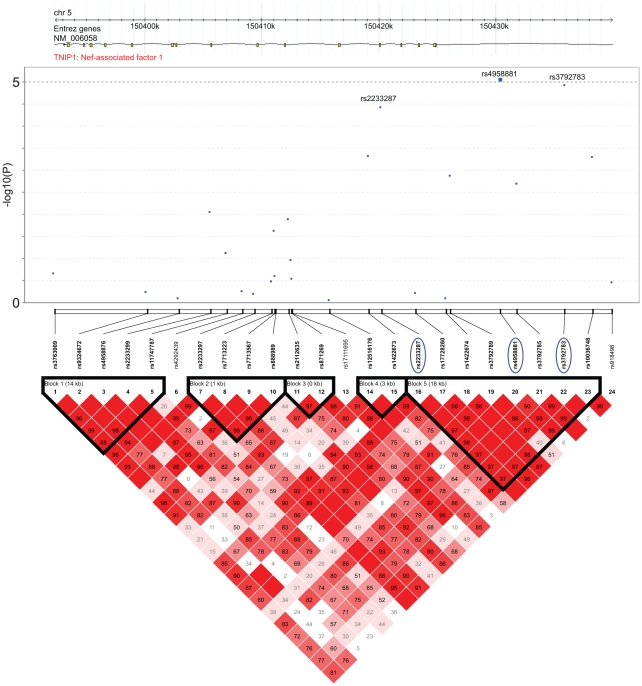
Association and linkage disequilibrium patterns at the TNIP1 gene.(A) Association of SNPs in TNIP1: −log10 P of the logistic regression test for association (y axis) in the GWAS stage of SNPs is plotted against their physical position. The continuous line corresponds to P<10−5, the minimum P value of the top 7 SNPs identified in stage 1. The three SNPs that were followed and replicated in stage 2 are highlighted by a blue circle. Positions are given as NCBI build. (B) Linkage disequilibrim patterns at the TNIP1gene: pairwise LD (D′) are indicated by color gradients: D′≥0.80, red; 0.5≤D′<0.8, pink; 0.2≤D′<0.5, light pink; D′<0.2, white. The 3 SNPs are in strong LD (r2 = 0.57/0.72 between rs3792783 and rs2233287/rs495881). Intron and exon structure of the TNIP1 gene are taken from the UCSC Genome Browser.